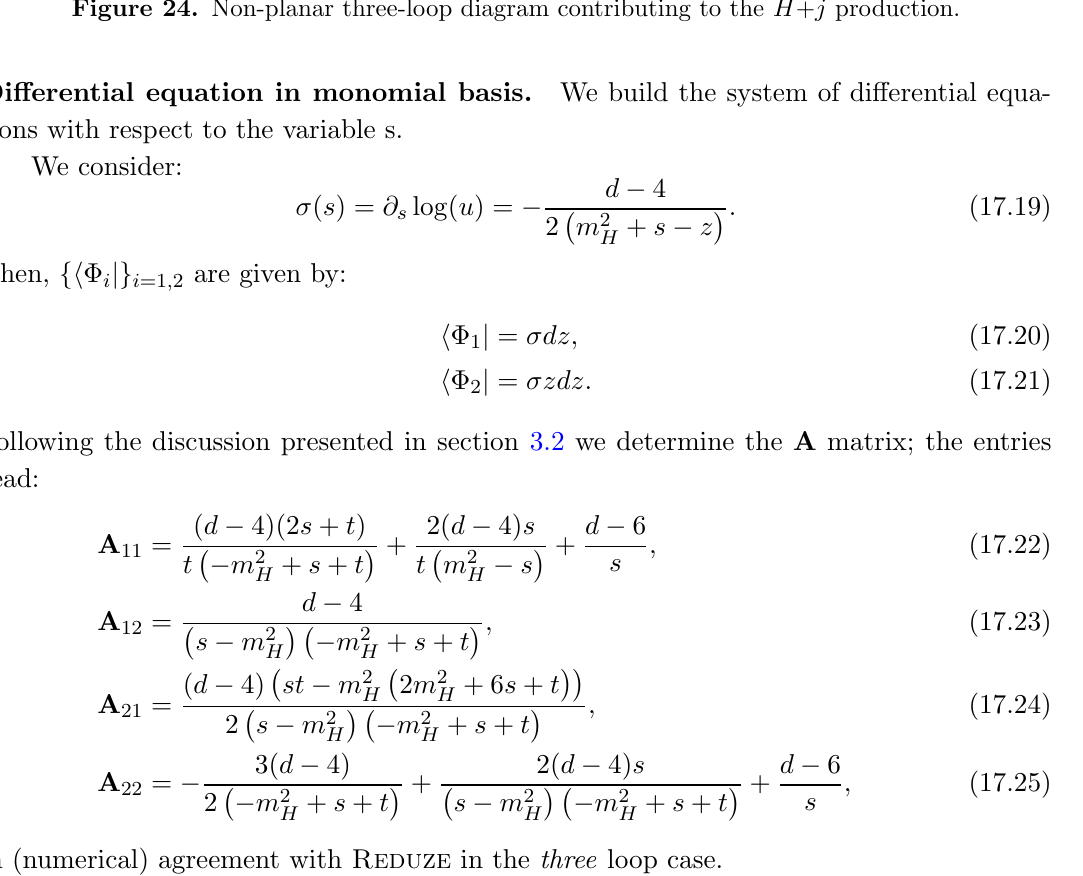
Figure 24. Non-planar three-loop diagram contributing to the H + j